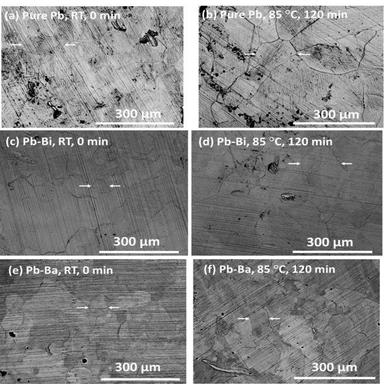
SEM images of pure Pb, Pb-Bi, and Pb-Ba samples at RT before heating and after heating to 85◦C for 120 min. (a) and (b) are images of pure Pb foil, (c) and (d) are images of Pb foil with 100 ppm of Bi, and (e) and (f) are images of Pb foil with 100 ppm of Ba.